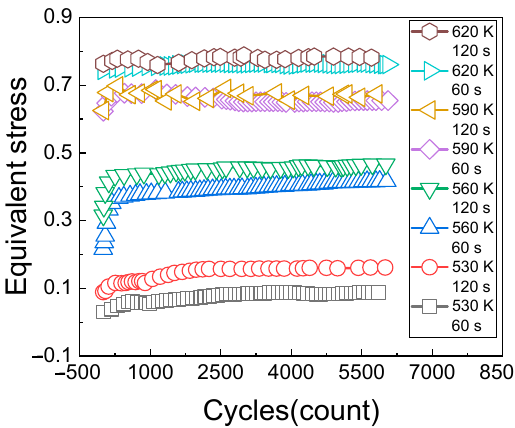
Figure 11. Equivalent stress changes with cycles.